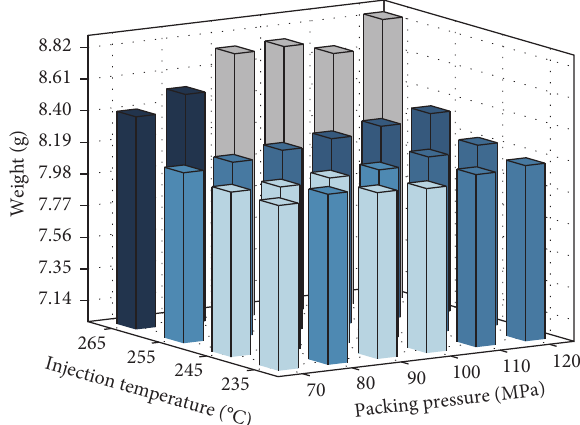
Figure 3: Product weight under varying process parameters.